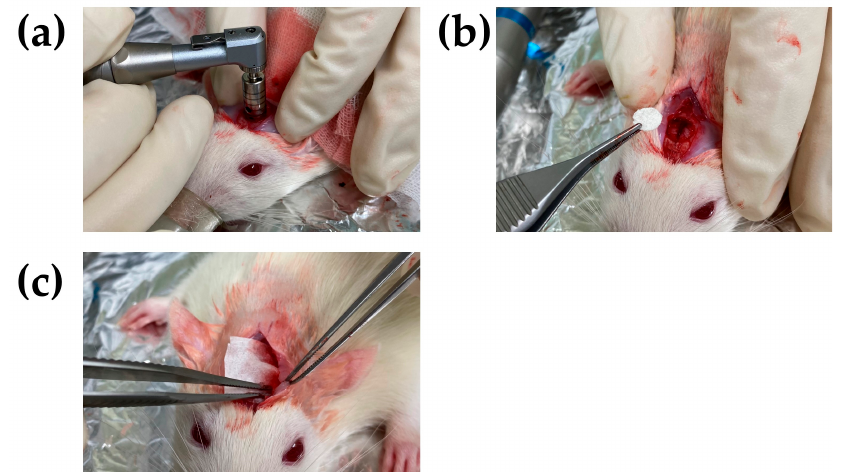
Figure 15. ( a ) Drilling a hole in rat cranial bone with trephine bur, ( b ) insertion of disk specimen in the cranial defect, ( c ) covering the defect with a self-prepared collagen membrane. Note: the membrane assisted in stopping bleeding, wound healing, preventing infection, fall prevention of the inserted construct, and bone formation, and disappeared within 8 weeks after insertion [56].